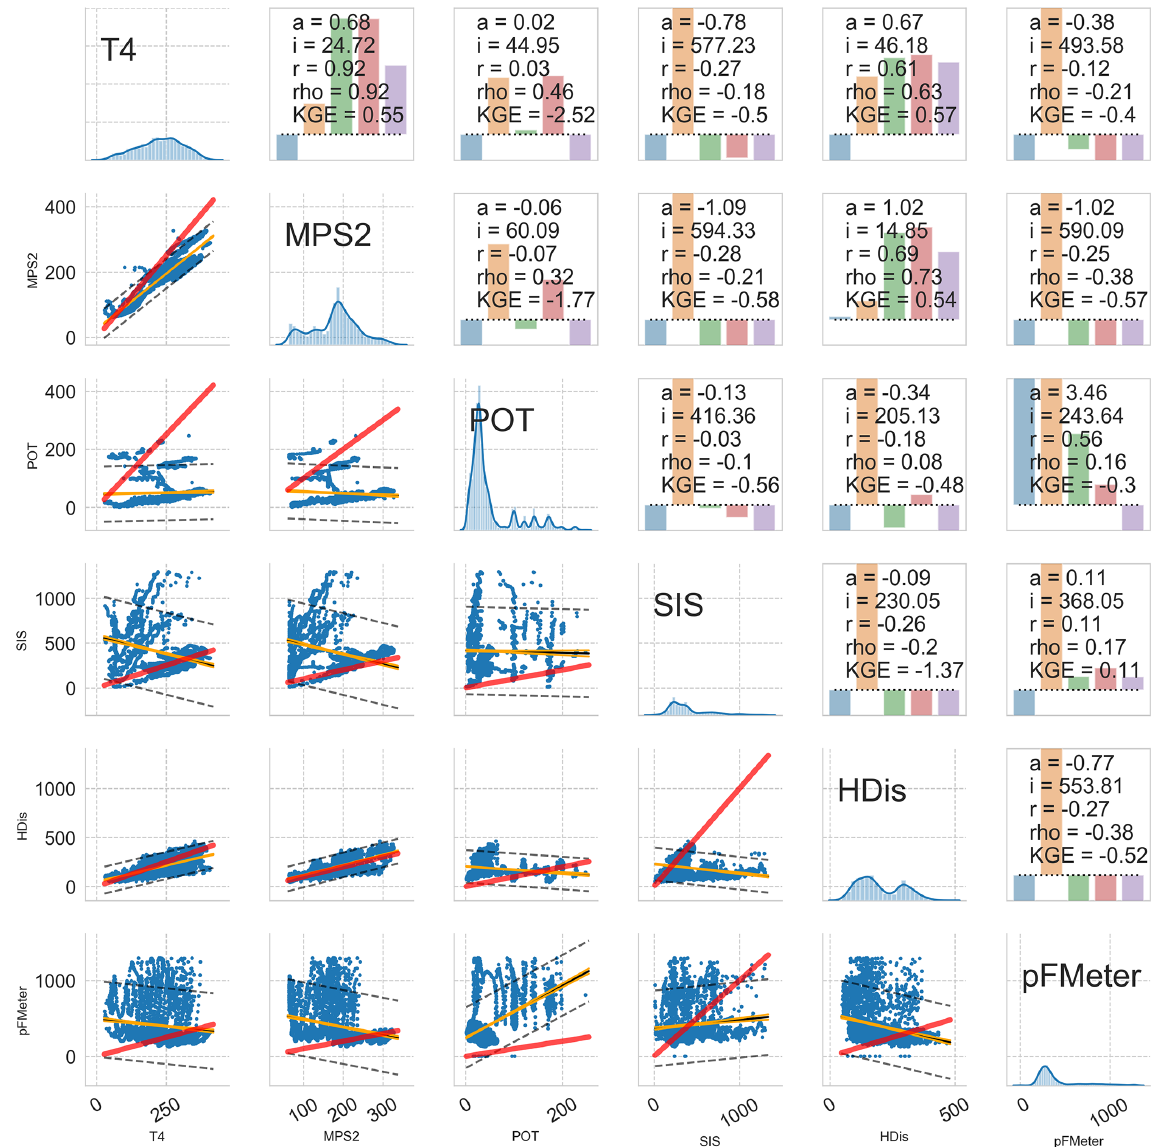
Figure A2. Correlation matrix of two references and the less plausible sensor systems for matric potential (given in hPa). Diagonal panels give histogram and kernel density distribution of 0.5h means of all sensors of one system. Lower half gives scatter plot (blue dots), linear regression (orange line), 0.95 predictive uncertainty bands (grey dashed lines) and the 1 : 1 line (red). The upper half reports the respective correlation measures, with a and i as scaling factor and intercept of the linear regression model, r as Pearson correlation coefficient, rho as Spearman rank correlation coefficient, and KGE as Kling–Gupta efficiency. These values are plotted as bars in the same order in the background, where a is plotted as deviation from unity and i is scaled with